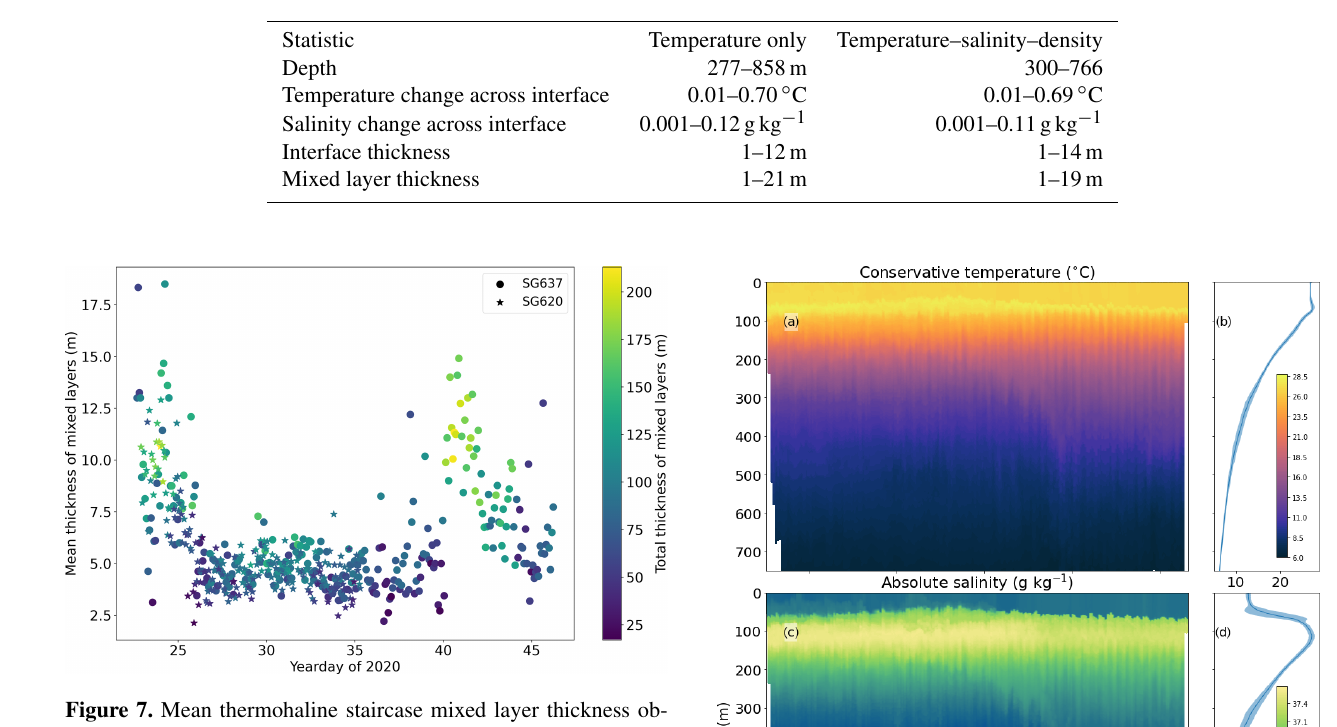
Table 3. Statistics on staircases. Ranges quoted are between the 2.5 and 97.5 percentiles, following VDB. Depth is the depth range over which staircases are identified. Temperature and salinity change across interfaces is the magnitude of change in these properties across the interfaces between adjacent mixed layers in a staircase.